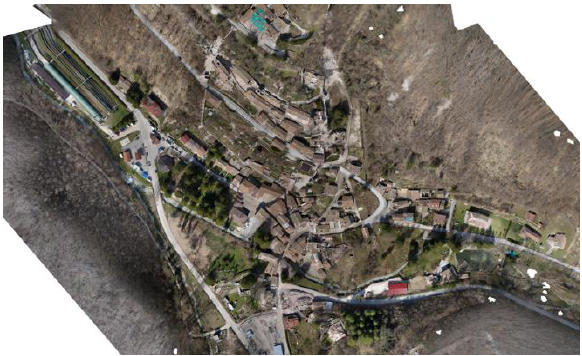
Figure 8. Orthophoto by UAV on Castelsantangelo sul Nera